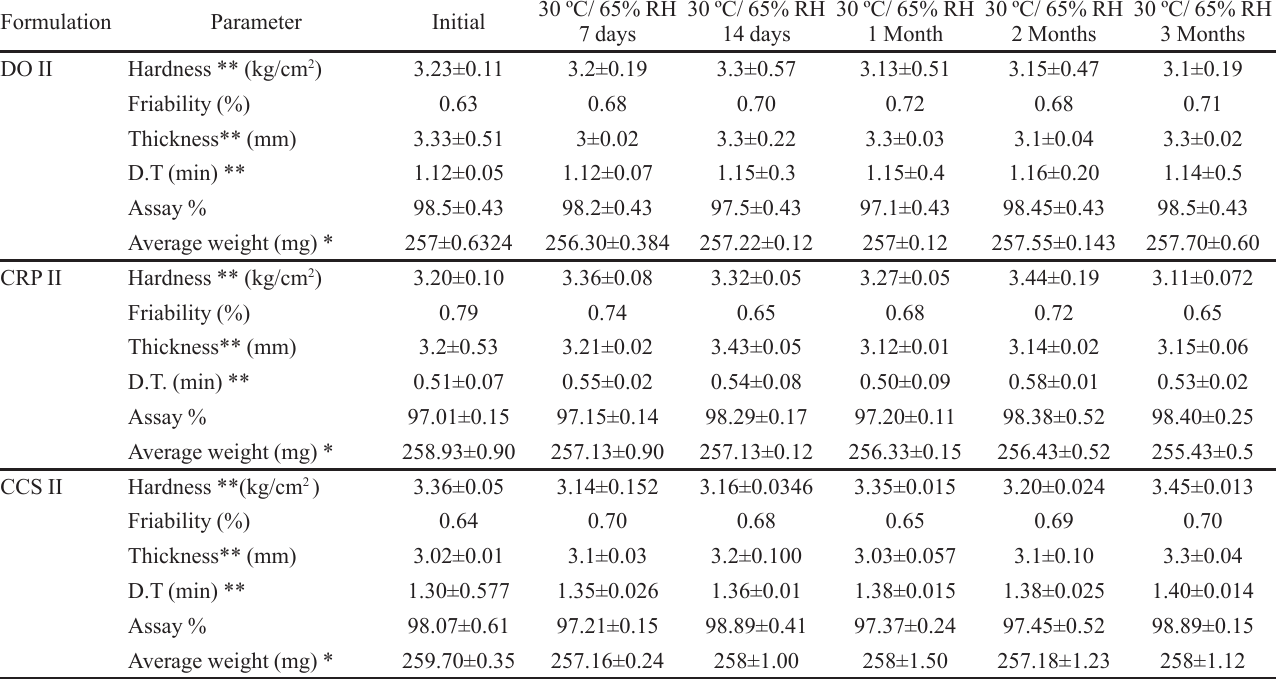
From the stability data in Table VIII and Table IX for batches DO II, CRP II and CCS III, it can be concluded that there were no significant changes in any parameters, and optimized batches i.e. DO II, CRP II and CCS II are therefore deemed stable. Hence, this product can be kept for a period of one year or more.